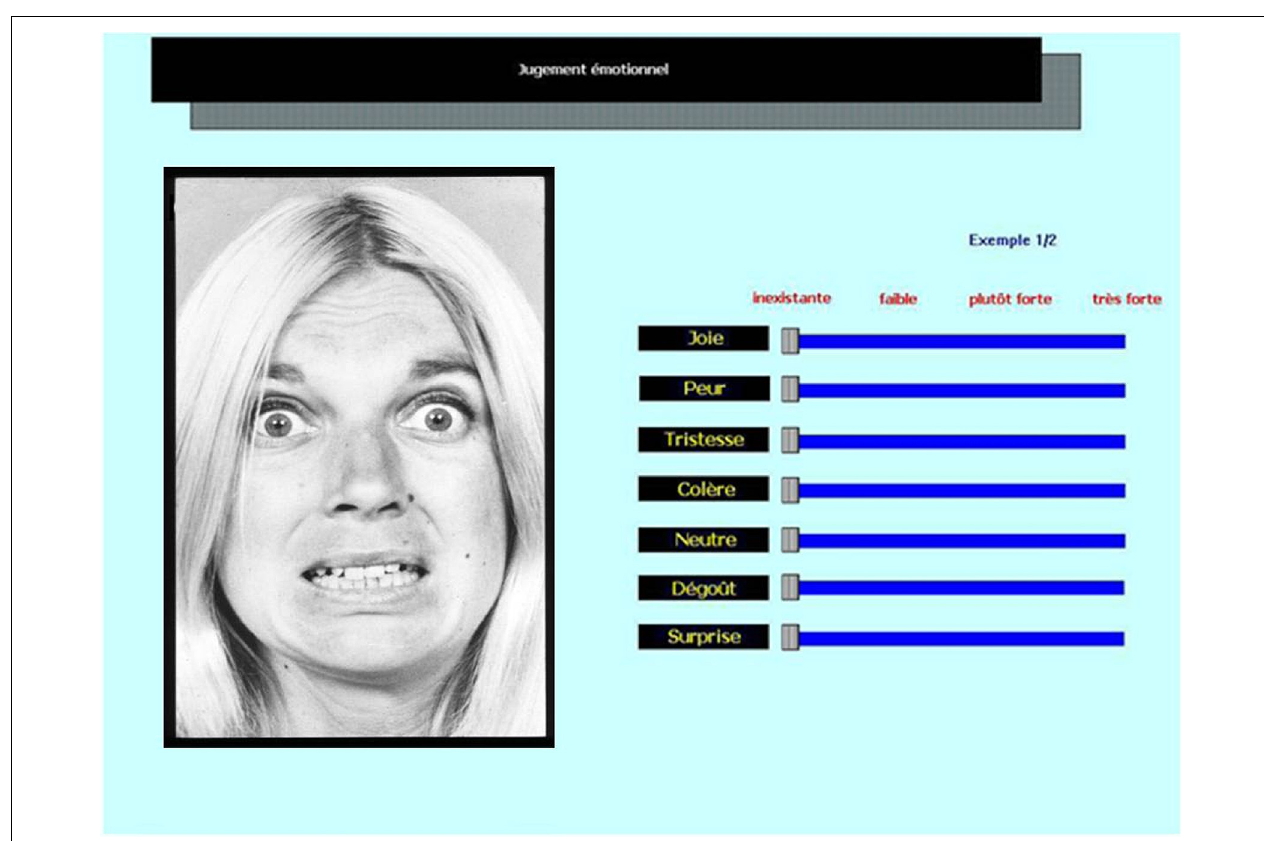
FIGURE 1 | Computer interface for the facial emotional